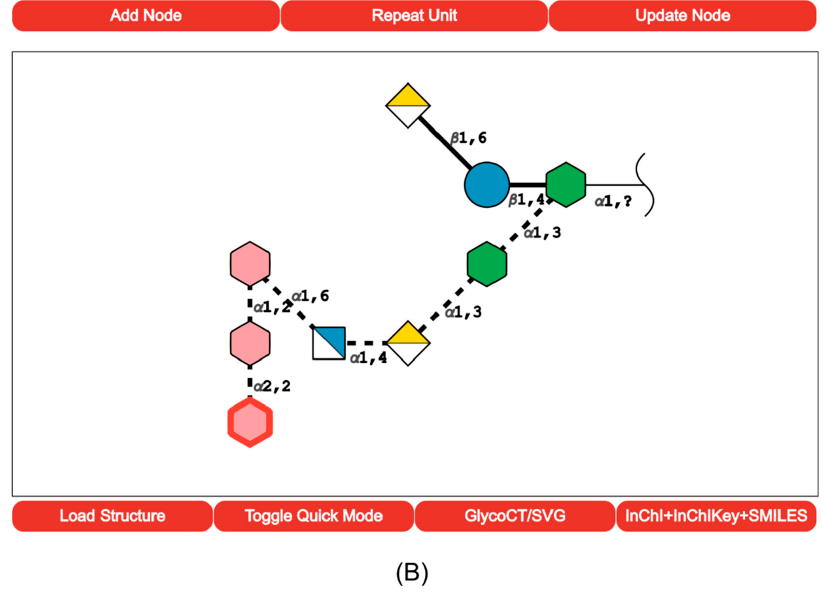
Figure 1. ( a ) Screenshot of the SugarSketcher interface after the completion of an N-glycan core carried out in the “quick mode”. The upper menu shows a selection of 12 monosaccharides more frequently observed in the composition of mammalian glycans. Monosaccharides are positioned following the option proposed in [16]. Linkage is indicated by the bond angle whereas anomericity by solid ( β ) or dashed ( α ) lines.; ( b ) Screenshot of the SugarSketcher interface after the completion of a glycan carried out in the “normal mode”. The top menu shows a much broader range of possible monosaccharides. The same positioning procedure applies.